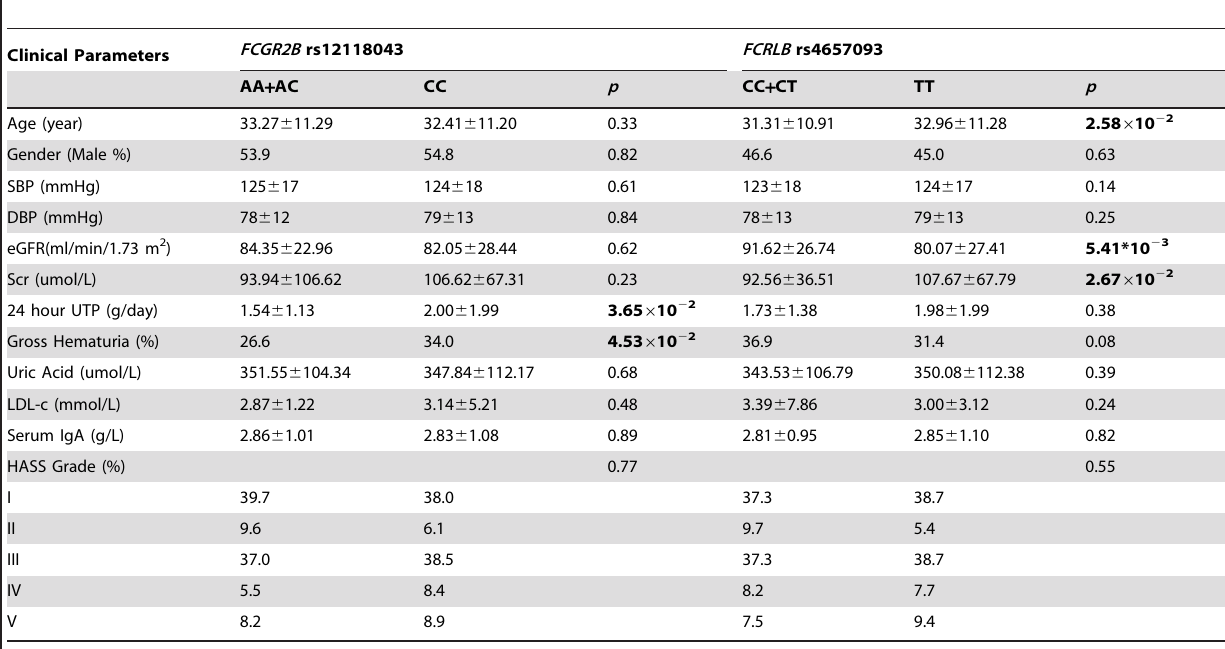
Table 3. Associations between Fc receptor gene polymorphisms and severity of IgAN.